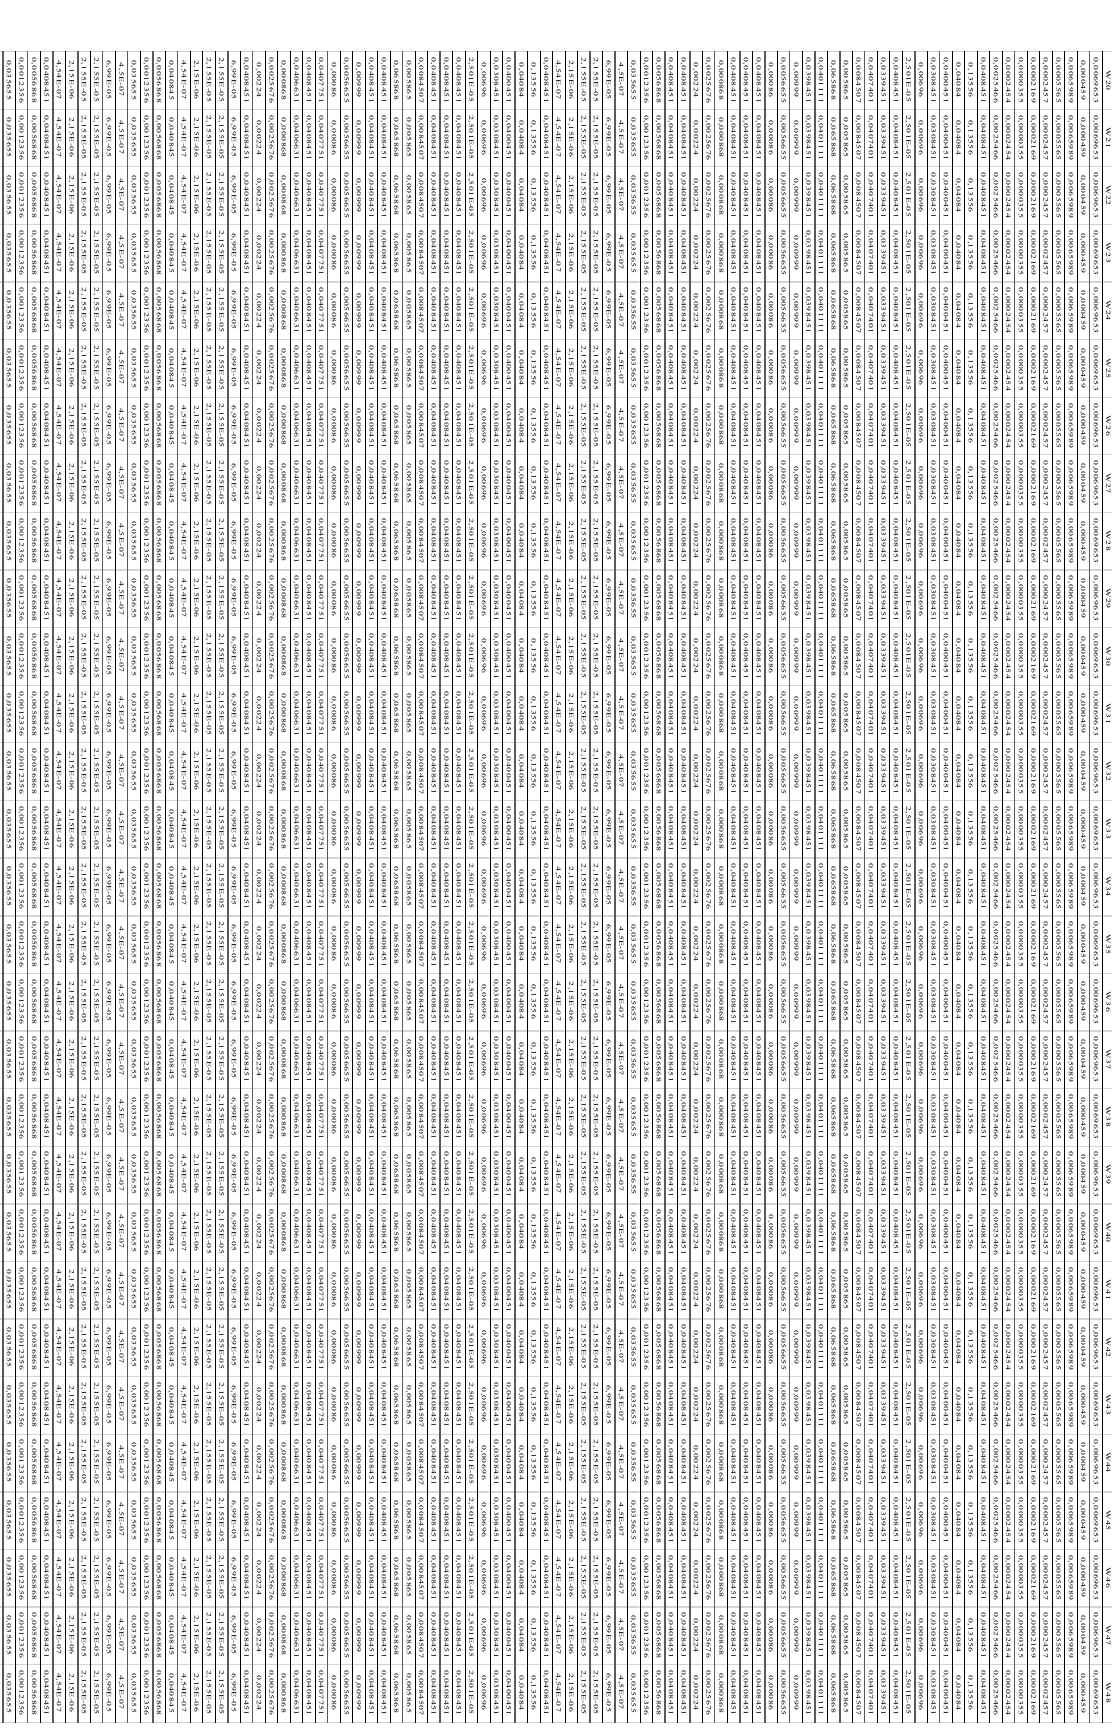
Figure A2. Limit super matrix of the ANP calculations (cont.)